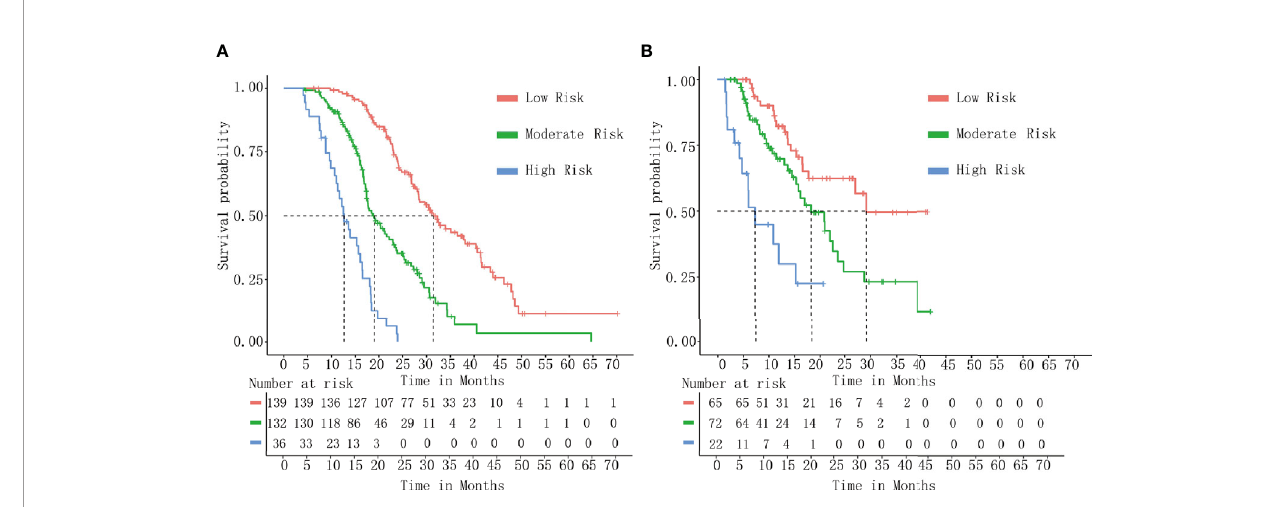
FIGURE 5 | Kaplan – Meier curve analysis. Survival curves strati fi ed by the risk score calculated using the developed prediction model [(low risk (<176), moderate risk (176 – 256), and high risk (>256)] in the training cohort (A) and the validation cohort (B)